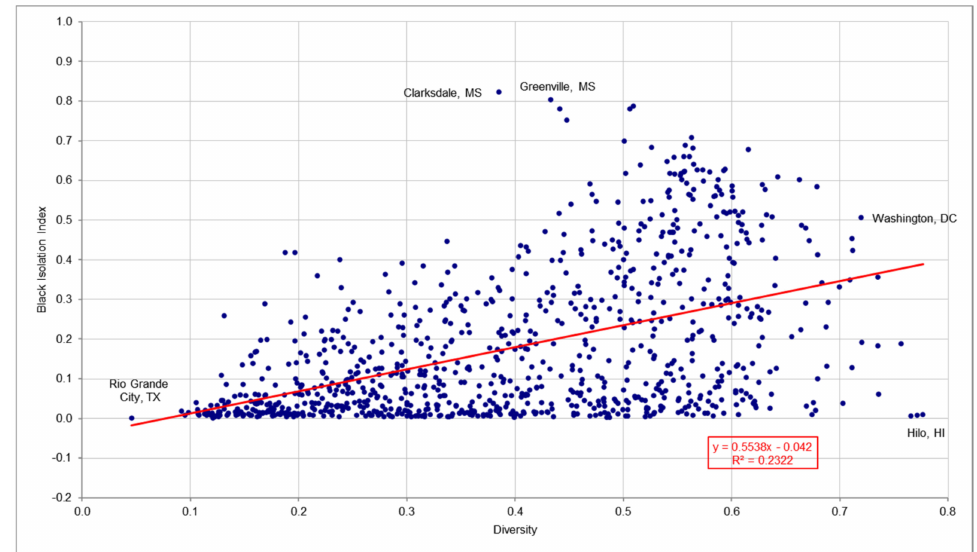
Figure 26. Relationship Between Diversity and black Isolation.